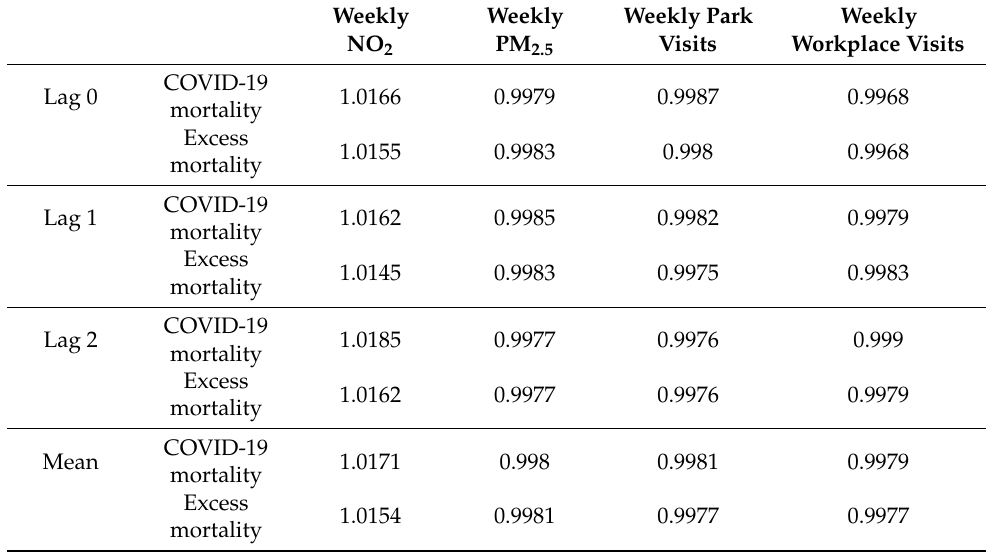
Table 3. Average country-level relative risks of weekly NO 2 , PM 2.5 , park visits, and workplace visits.